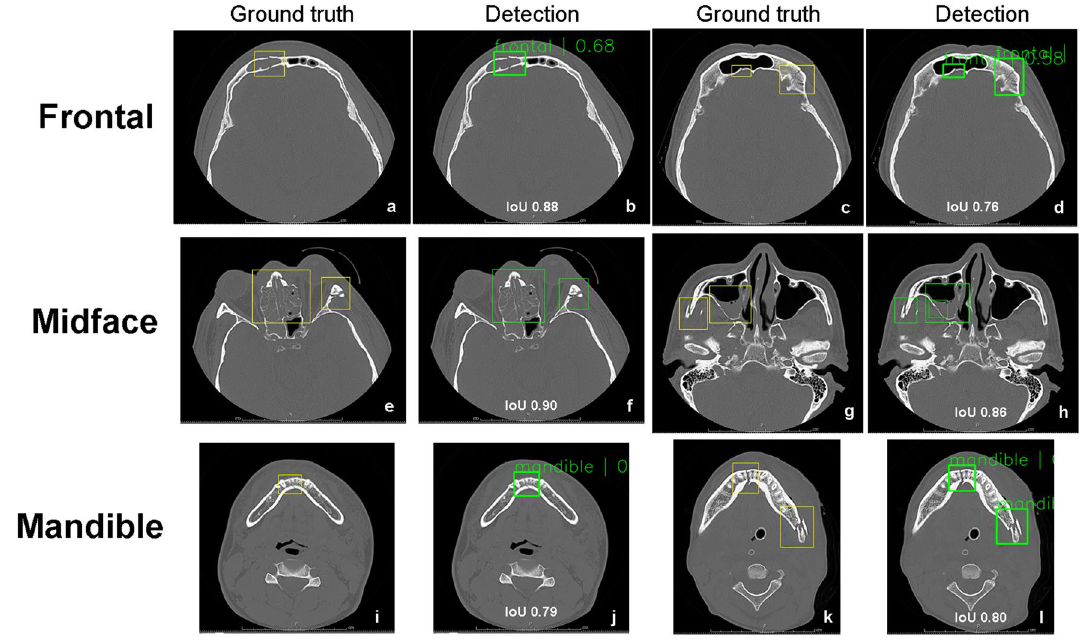
Figure 5. Examples of ground truth and detection bounding boxes of faster R-CNN on CT images from an independence test set. The yellow boxes represent boxes annotated manually by oral and maxillofacial surgeons of frontal ( a , c ), midface ( e , g ), and mandibular ( i , k ) fractures. The green boxes are the true positive output for detection of frontal fractures with IoU of 0.88 and 0.76 ( b , d ), midface fractures with IoU of 0.90 and 0.86 ( f , h ), and mandibular fractures with IoU of 0.79 and 0.80 ( j , l ). IoU Intersection over